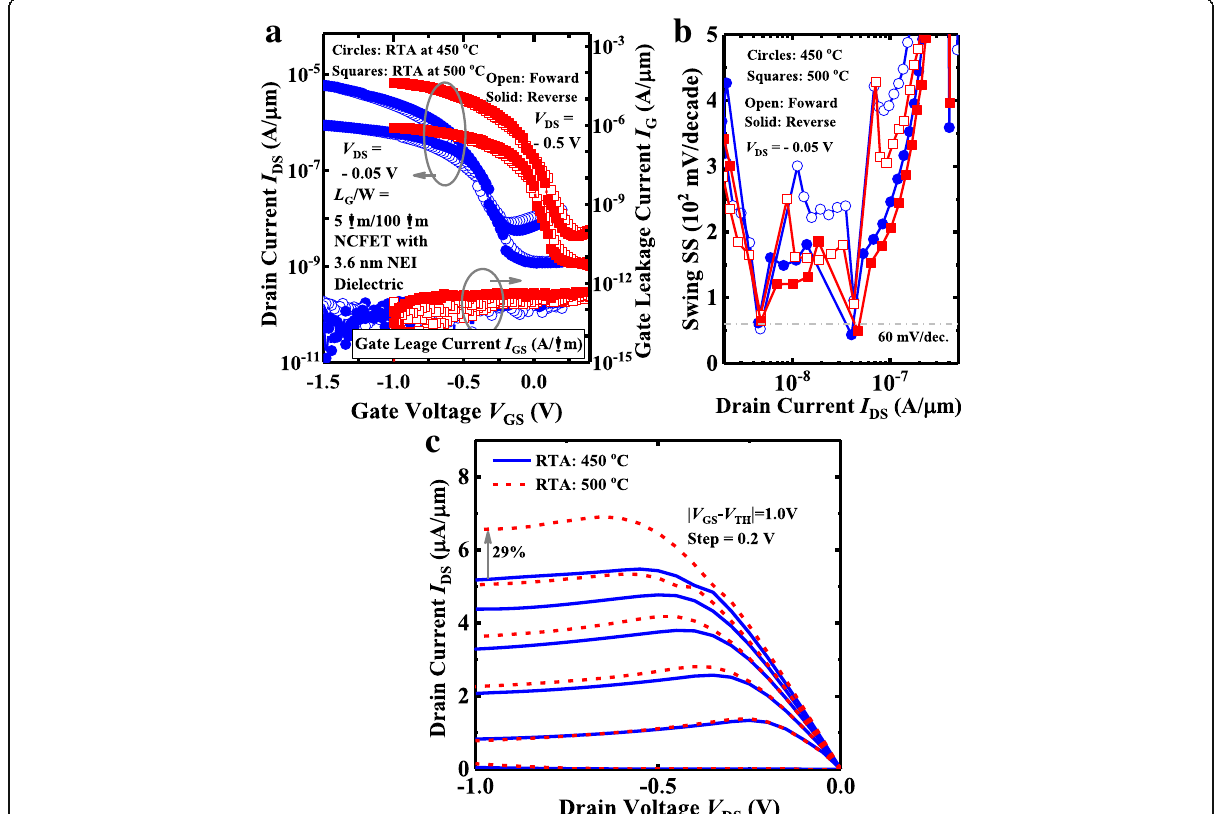
Fig. 7 a Measured I DS - V GS and I G - V GS curves of NCFETs with 3.6-nm NEI annealed at 450 °C and 500 °C. b NEI NCFETs has the sub-60 mV/decade points for a V DS value of − 0.05 V. c I DS - V DS curves for the NEI NCFETs showing the obvious NDR phenomena. NC transistor annealed at 500 °C achieves a 29% I DS improvement compared to the device with RTA at 450 °C at a supply voltage of 1.0